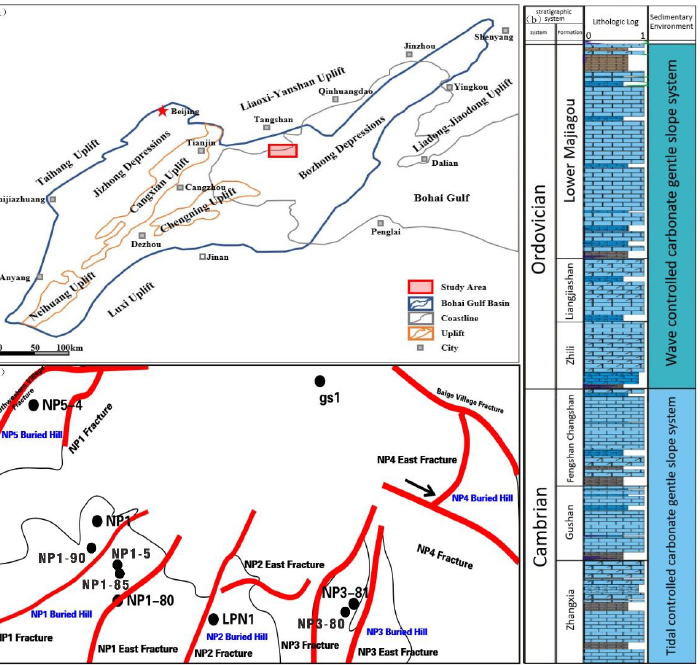
Figure 1. Comprehensive map of the regional geology. ( a ) Tectonic division; ( b ) The lithology characteristics; ( c ) Well location in study